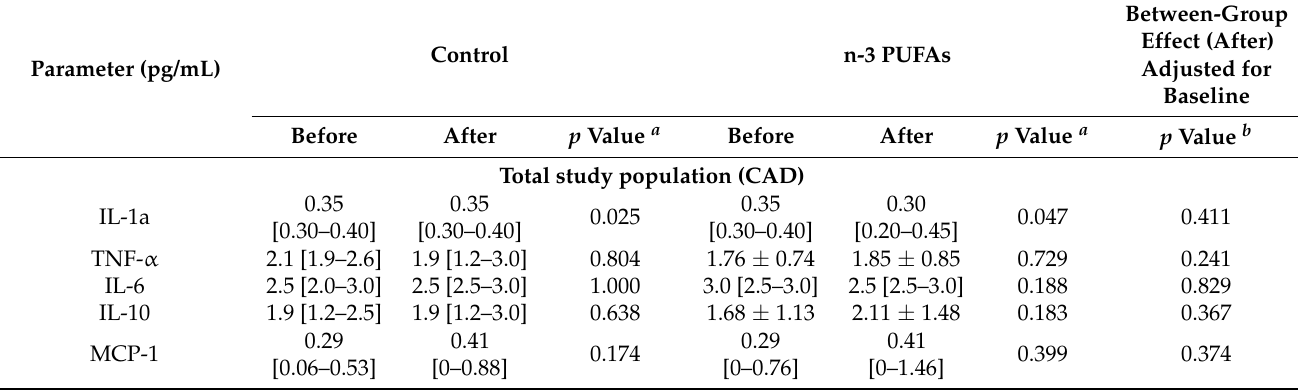
Table 6. Effect of regular (control group) and n-3 PUFA-enriched hen eggs (n-3 PUFAs group) consumption on serum pro- and anti-inflammatory cytokines and chemokines protein concentration in the total population (CV) and in the two subgroups (Ac-CV patients and Ch-CV